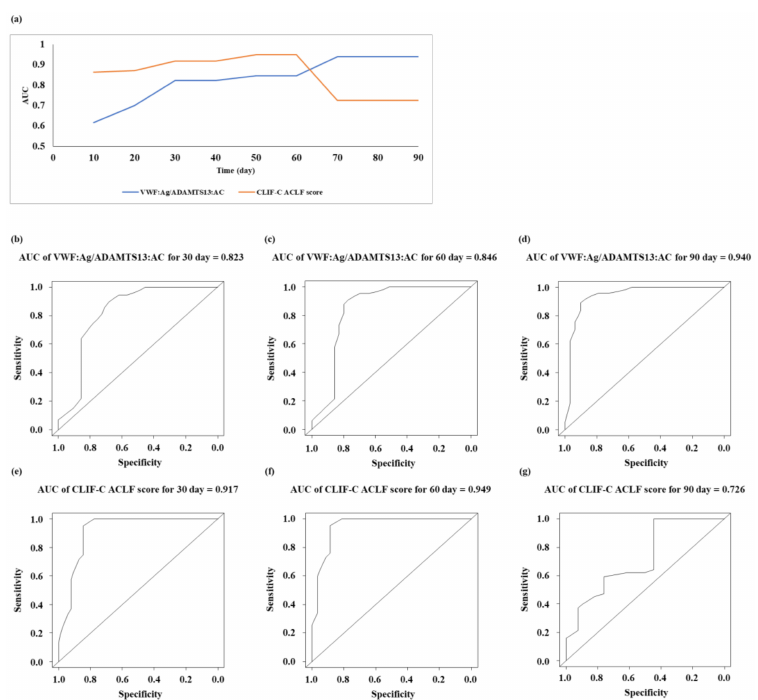
Figure 4. ROC curve for predicting prognosis in the post-ACLF group by VWF:Ag/ADAMTS13:AC and CLIF-C ACLF score. ( a ) The time-dependent AUCs of VWF:Ag/ADAMTS13:AC and CLIF-C ACLF score according to days of follow-up. ( b – d ) The ROC curve for predicting prognosis in the post-ACLF group by VWF:Ag/ADAMTS13:AC at 30, 60, and 90 days of follow-up; the AUCs of ROC curves are 0.823, 0.846, and 0.940, respectively. ( e – g ) The ROC curve for predicting prognosis in the post-ACLF group by CLIF-C ACLF at 30, 60, and 90 days of follow-up; the AUCs of ROC curves are 0.917, 0.949, and 0.726, respectively. ROC, receiver operating characteristic; AUC, area under curve; CLIF-C, the chronic liver failure consortium; ACLF, acute-on-chronic liver failure; ADAMTS13, a disintegrin-like and metalloproteinase with thrombospondin type 1 motifs 13; ADAMTS13:AC, ADAMTS13 activity; VWF, von Willebrand factor; VWF:Ag, VWF antigen; VWF:Ag/ADAMTS13:AC, the ratio of VWF:Ag to ADAMTS13:AC.